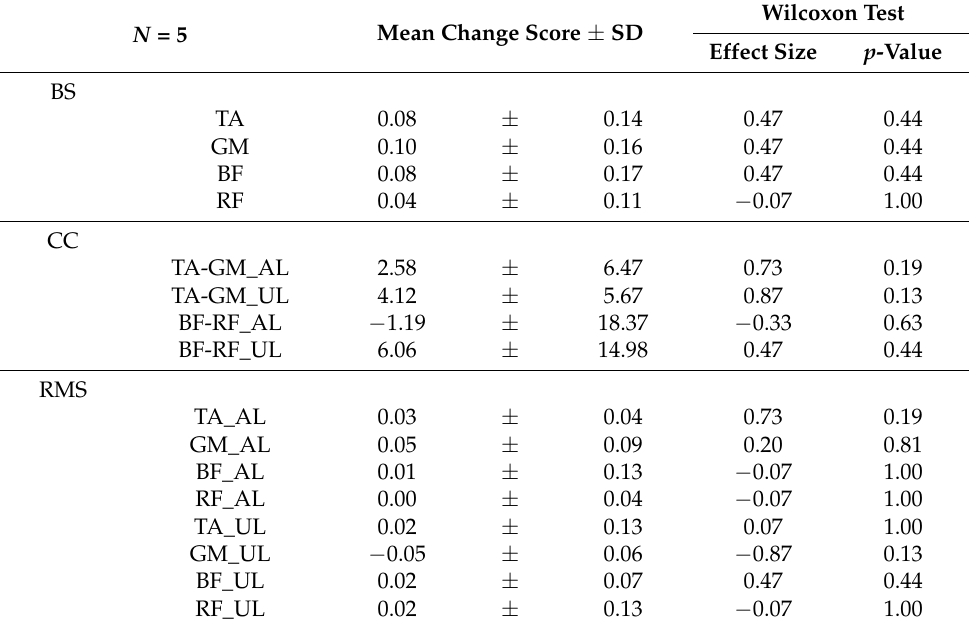
Table 5. Comparison of T1 and o-RAGT 1 change scores of each sEMG outcome. N =